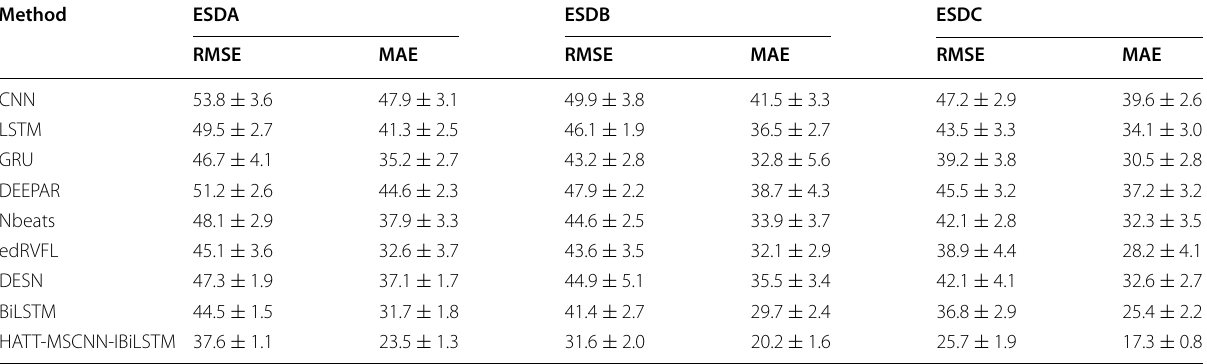
Table 4 Test RMSE and MAE for different methods Method ESDA